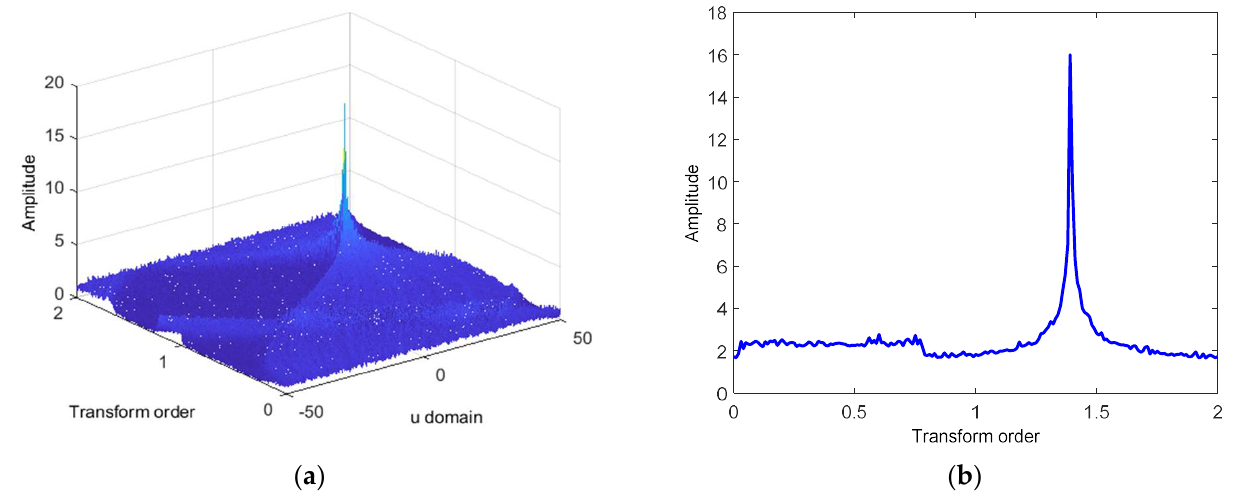
Figure 2. ( a ) FrFT spectrum of the chirp signal and ( b ) schematic diagram of the transform projection in the order domain.